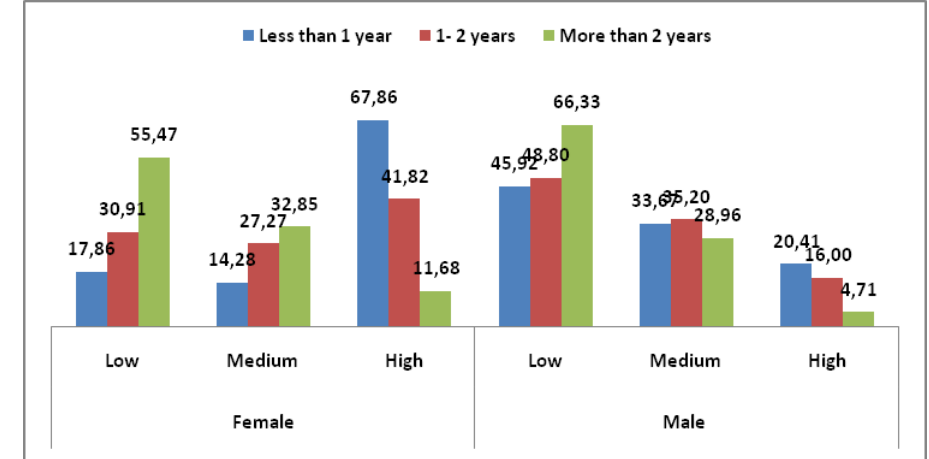
Figure 8: Percentage distribution of young people who transited from school to the first job by level of education